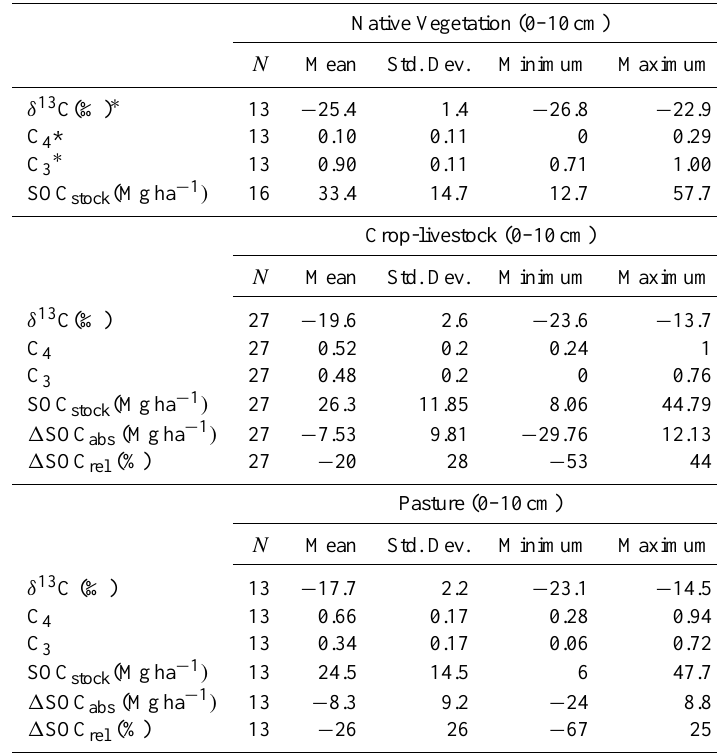
Table 2. Mean, standard-deviation (Std. Dev.), minimum and maximum for δ 13 C, C 3 proportion (C 3 ) , C 4 proportion (C 4 ) , and carbon stocks (SOC stock ) at 0–10cm soil depth layer for forest, crop-livestock systems and pasture soils at the paired study sites. 1 SOC abs is the difference between the carbon soil stock of native vegetation and crop-livestock systems and pasture soils obtained in the paired study sites. 1 SOC rel is the same difference expressed as percentage. Carbon losses are indicated by a minus sign